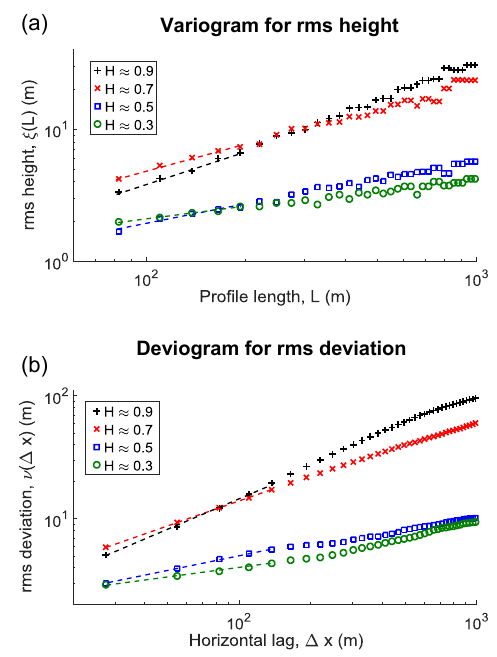
Figure 2. (a) Variogram for rms height, ξ , versus profile length L (log–log scale). (b) Deviogram for rms deviation, ν , versus horizontal lag, (cid:49)x (log–log scale). The plots correspond to sub- glacial terrain profiles in Fig. 1. The Hurst exponent is estimated from the linear gradient of the first five data points (indicated by dashed lines). These space-domain plots are (approximate) equiv- alents to frequency-domain roughness power spectra, and smaller length scales correspond to higher